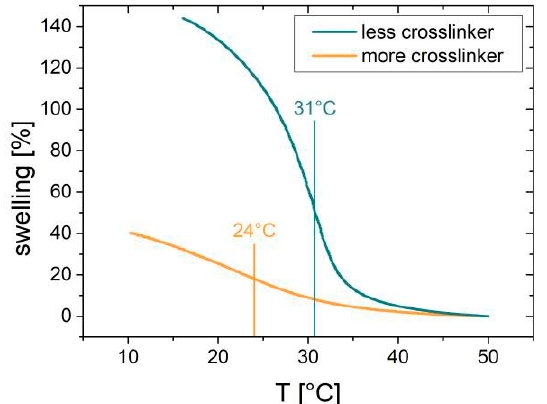
Figure 2. Swelling (film thickness normalized to the value at 50 °C) vs. temperature T curves from spectroscopic ellipsometry in water for two differently cross-linked 100 nm p(NIPAAm-co-DEGDVE) samples. Evaluation of the LCST as the point of inflection.